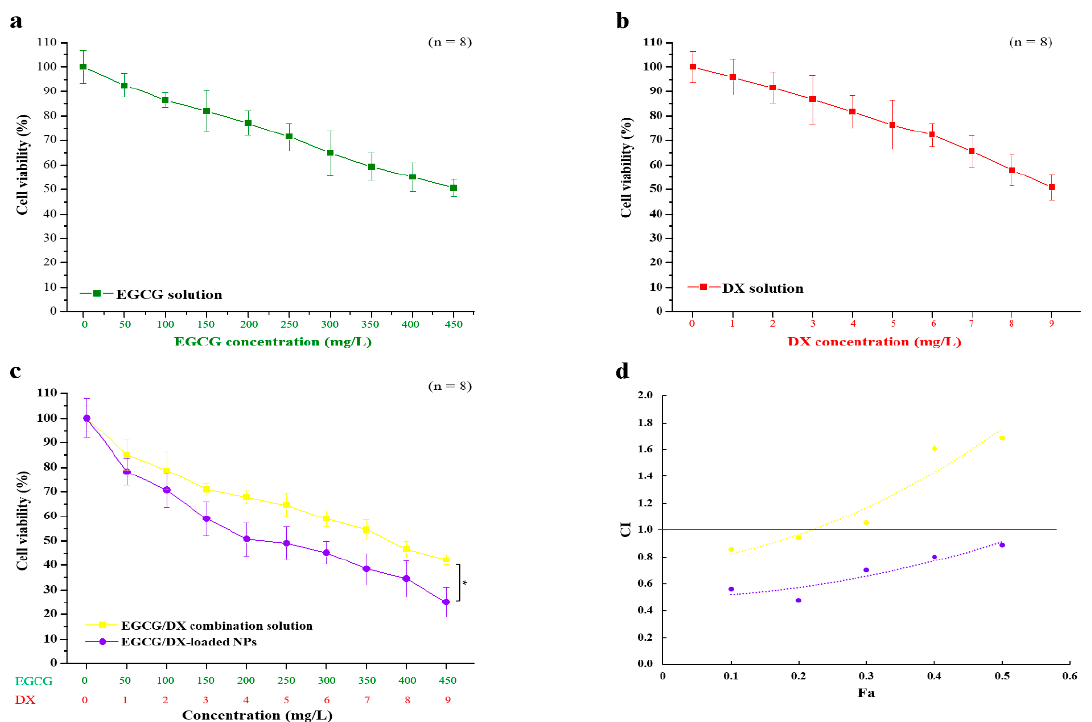
Figure 4. The effects of EGCG, DX, EGCG/DX combination solution, and EGCG/DX-loaded NPs on Luc MKN45 cell viability: ( a ) A 2.0 h dose response treatment with EGCG; ( b ) A 2.0 h dose response treatment with DX; ( c ) A 2.0 h dose response treatment with EGCG/DX solution and EGCG/DX-loaded NPs; cell viability was assessed at 24.0 h for a–c; data are expressed as mean ± SD ( n = 8). Asterisk * represents statistically significant difference with p value < 0.05. ( d ) Combination index–fraction affected (CI-Fa) plot; CI < 1.0 indicates synergistic effects, CI = 1.0 indicates additive effects and CI > 1.0 indicates antagonistic effects of the combined drug action. Dots below the slanted line indicate synergistic effects.